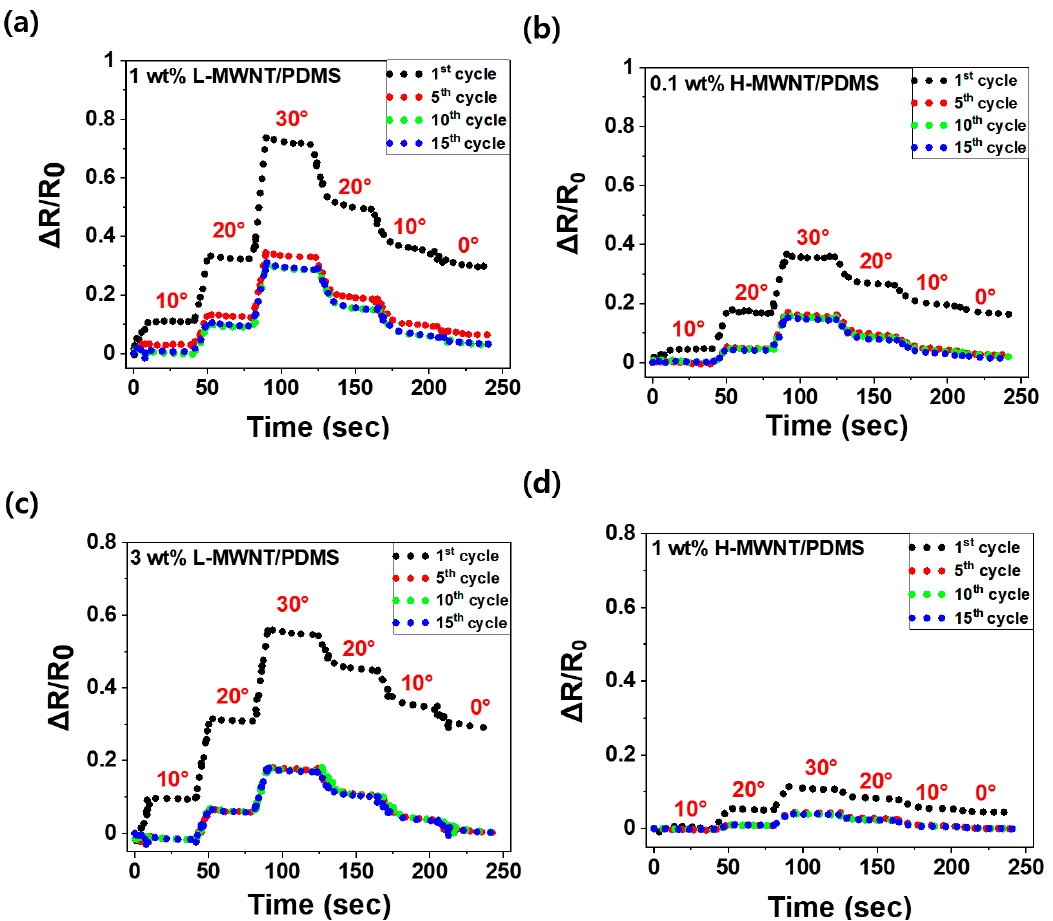
Figure 5. Δ R/R 0 value according to bending angle for MWNT/PDMS composites under Figure 5. ∆ R / R 0 value according to bending angle for MWNT / PDMS composites under discontinuous 15 discontinuous 15 cyclic bending and releasing deformations: ( a ) 1 wt.% L-MWNT/PDMS, ( b ) 0.1 cyclic bending and releasing deformations: ( a ) 1 wt.% L-MWNT / PDMS, ( b ) 0.1 wt.% H-MWNT / PDMS, wt.% H-MWNT/PDMS, ( c ) 3 wt.% L-MWNT/PDMS, ( d ) 1 wt.% H-MWNT/PDMS. (red text: bending ( c ) 3 wt.% L-MWNT / PDMS, ( d ) 1 wt.% H-MWNT / PDMS. (red text: bending state of each state of each angle).